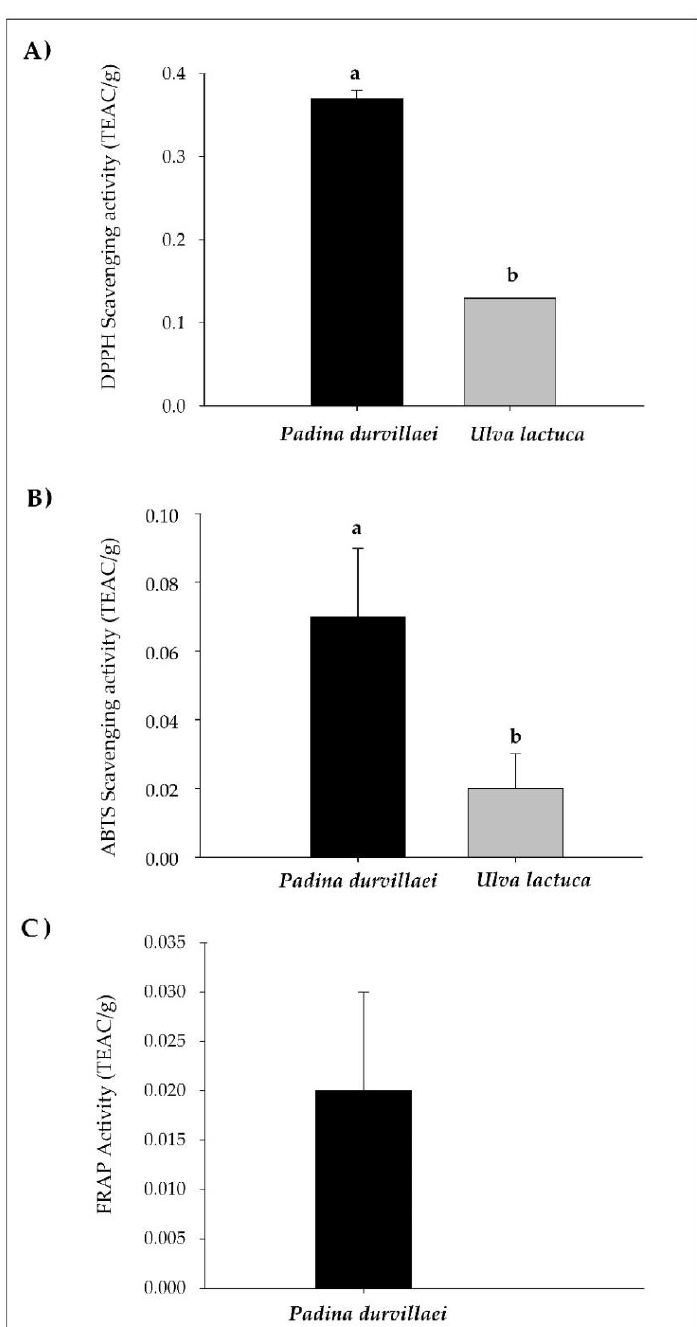
Figure 1. In vitro antioxidant activity of seaweed extracts of Padina durvillaei and Ulva lactuca assessed by different methods: ( A ) DPPH scavenging activity; ( B ) ABTS scavenging activity; and ( C ) FRAP activity. Bars represent mean of triplicates ± SD; different letters are significantly different at p < 0.05. TEAC/g, mmol of Trolox equivalent of antioxidant activity per gram of seaweed extract. The quantification of basic PGRs (Figure 2C) showed that tZ is the most abundant hormone in the U . lactuca extract (10.95± 4.31 ng/g). On the other hand, IP concentrations were similar in both extracts (4.41 1.85 ng/g in P . durvillaei and 4.57 ± 0.38 ng/g in U . lactuca ). DHZ concentrations were low in both extracts, with 1.09 ± 0.44 ng/g in P . durvillaei and 0.77 ± 0.09 ng/g in U . lactuca .